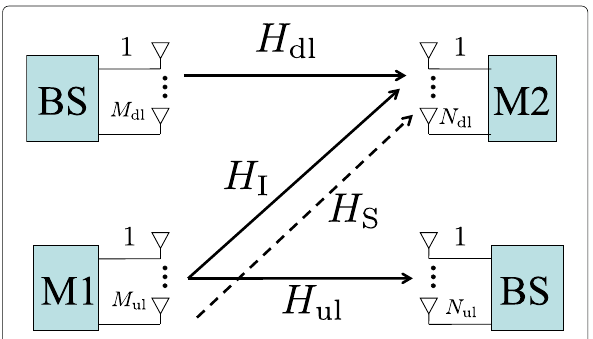
Fig. 2 Channel model: ( M dl , N dl , M ul , N ul ) side-channel-assisted MIMO full-duplex